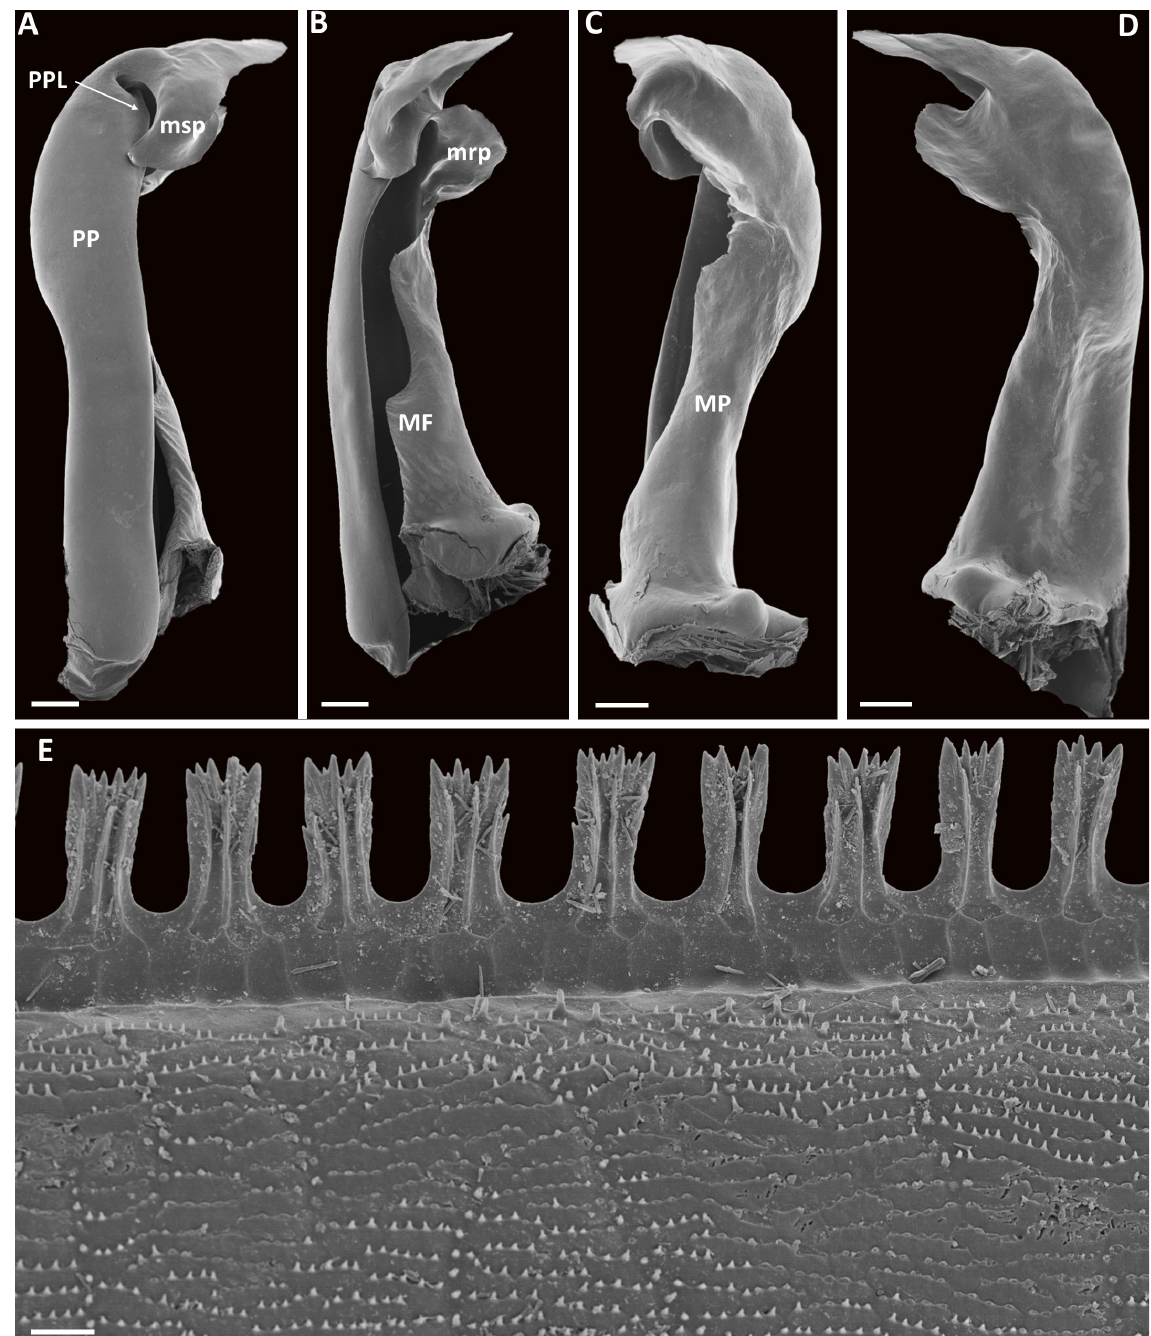
Fig. 38. Geotypodon cristinae sp. nov., holotype, ♂ (NHMD 621736). A–D . Left gonopod coxa. A. Anterior view. B. Mesal view. C. Lateral view. D. Posterior view. E . Midbody dorsal limbus. Abbreviations: MF = metaplical flange; MP = metaplica; mrp = mesad rounded process; msp = metaplical spinelike process; PP = proplica; PPL = proplical lobe. Scale bars: A–D = 0.2 mm; E = 0.01